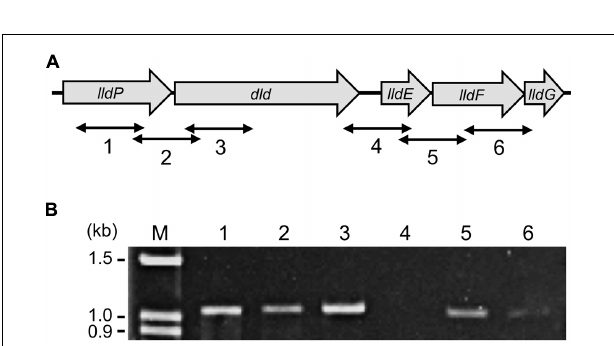
FIGURE 3 | Organization and transcriptional units of the dld and lld genes. (A) Schematic illustration of the organization of the dld and lld genes. Bidirectional arrows indicate target regions of the RT-PCR analysis. (B) RT-PCR of the dld and lld genes. RNA was extracted from WT cells grown aerobically in MM containing 10 mM DL -lactate until the logarithmic growth phase. Lane numbers correspond to the target regions shown in A . Left-side numbers indicate molecular sizes (kb) of bands in the marker (lane